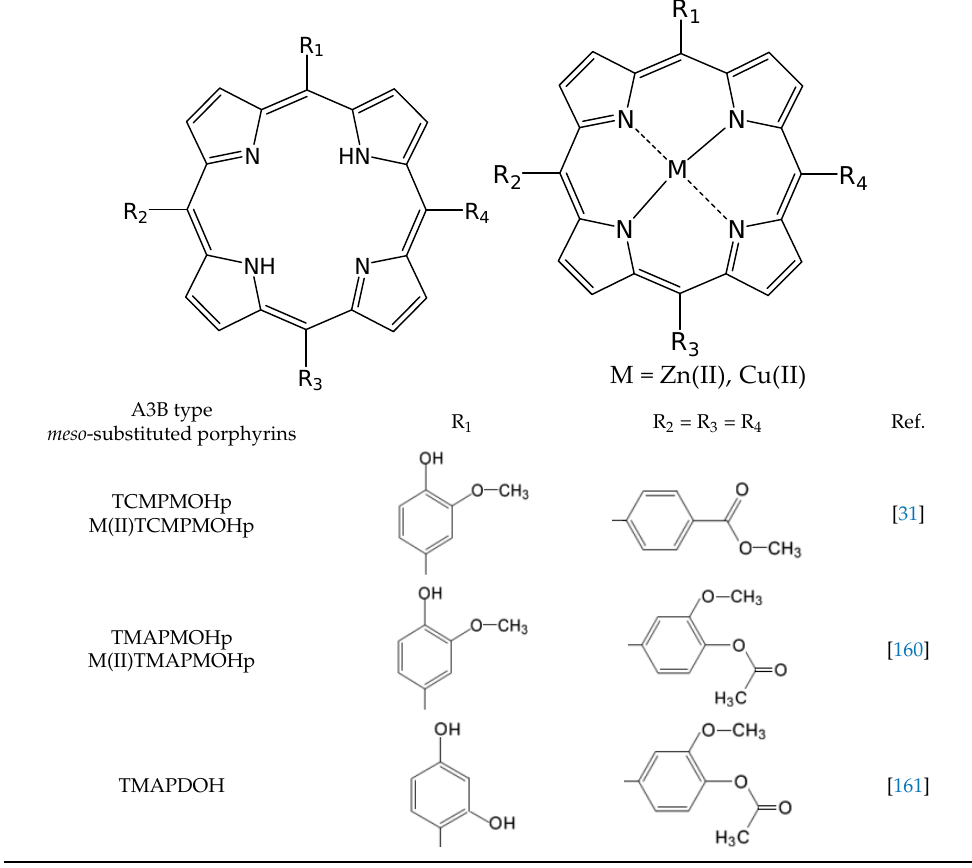
Table 2. Unsymmetrical A3B and A2B2 type meso- substituted porphyrins.